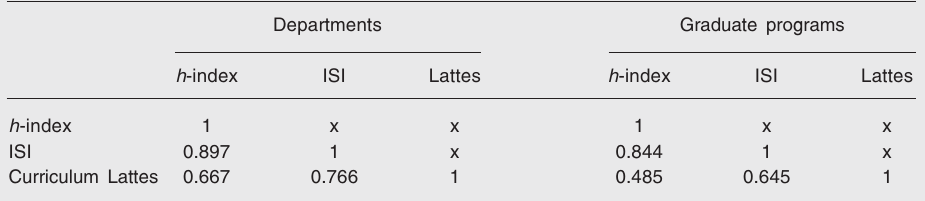
Table 4. Pearson’s correlation coefficients between number of papers indexed by the Thompson Institute of Scientific Information (ISI), total number of papers in Curriculum Lattes and the h -index for departments and graduate programs of the Faculdade de Filosofia, Ciências e Letras de Ribeirão Preto, USP.